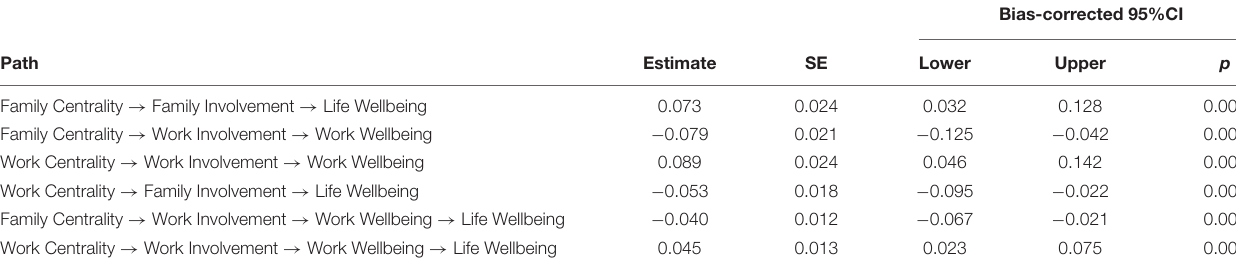
TABLE 6 | Summary of estimates and bias-corrected bootstrapped 95% confidence